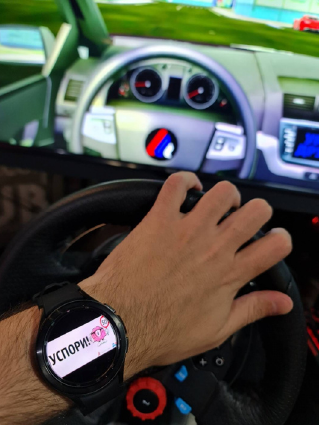
Figure 2. Driving simulator—smartwatch.